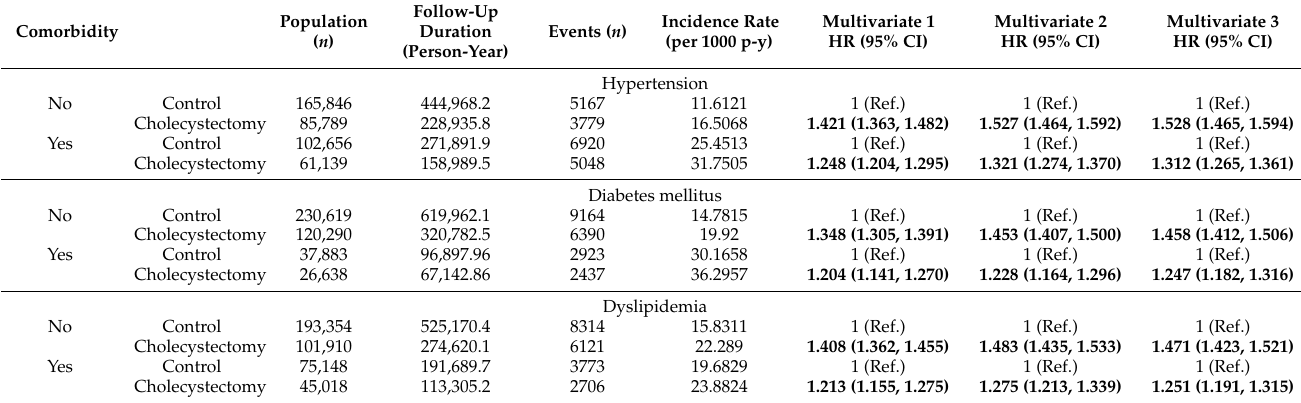
Table 3. Comorbidity and adjusted hazard ratio of heart disease